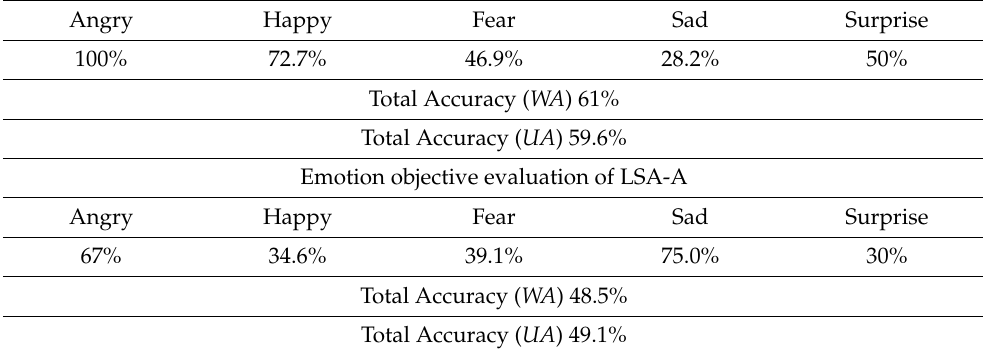
Table 2. Emotion objective evaluation of